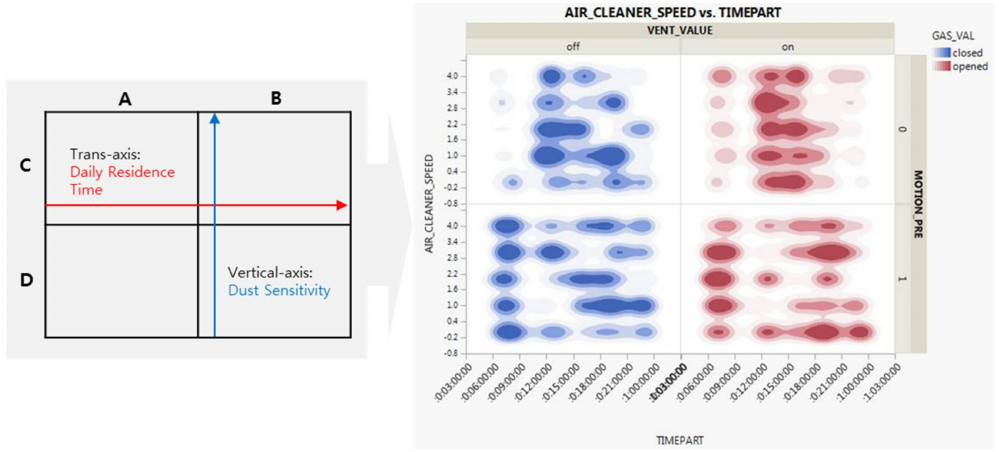
Figure 6. Four-dimensional clusters and variable distributions.